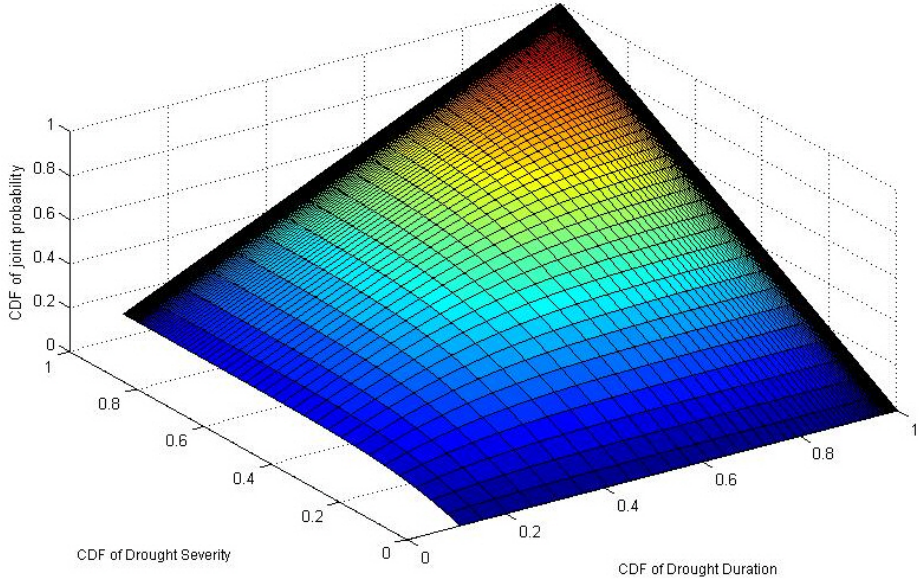
Figure 10. Joint cumulative distribution function (CDF) of the Sacramento River basin drought.